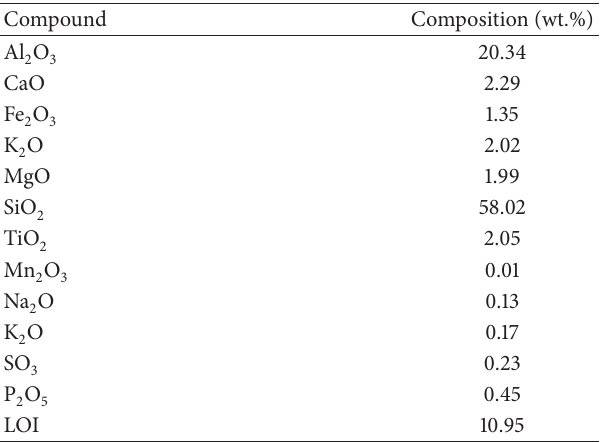
Table 1: Chemical composition of